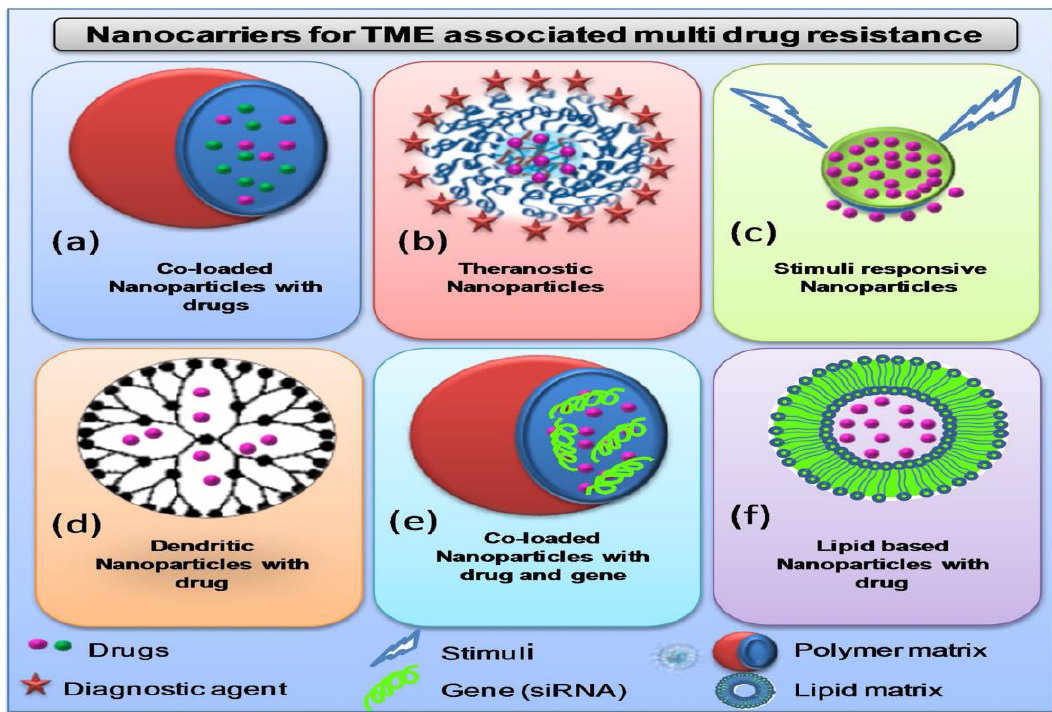
Figure 6. Different nanocarriers being utilized for targeting TME to overcome multi-drug resistance: ( a ) Nanoparticles loaded with two different drugs for co-delivery at target site for synergistic therapeutic action. ( b ) Theranostic nanoparticles co-loaded with both therapeutic and diagnostic agents. ( c ) Stimuli responsive nanoparticles respond against different components of TME such as pH change, ions change, different oxygenation. ( d ) Multifunctional branched polymeric dendrimer- based nanocarrier loaded with drugs. ( e ) Nanoparticles loaded with both drugs and nucleic acids (siRNA, miRNA) for synergistic therapeutic action ( f ) Liposomes loaded drugs for targeted delivery. Reproduced from Ref. [24], (2022), with permission from Elsevier.